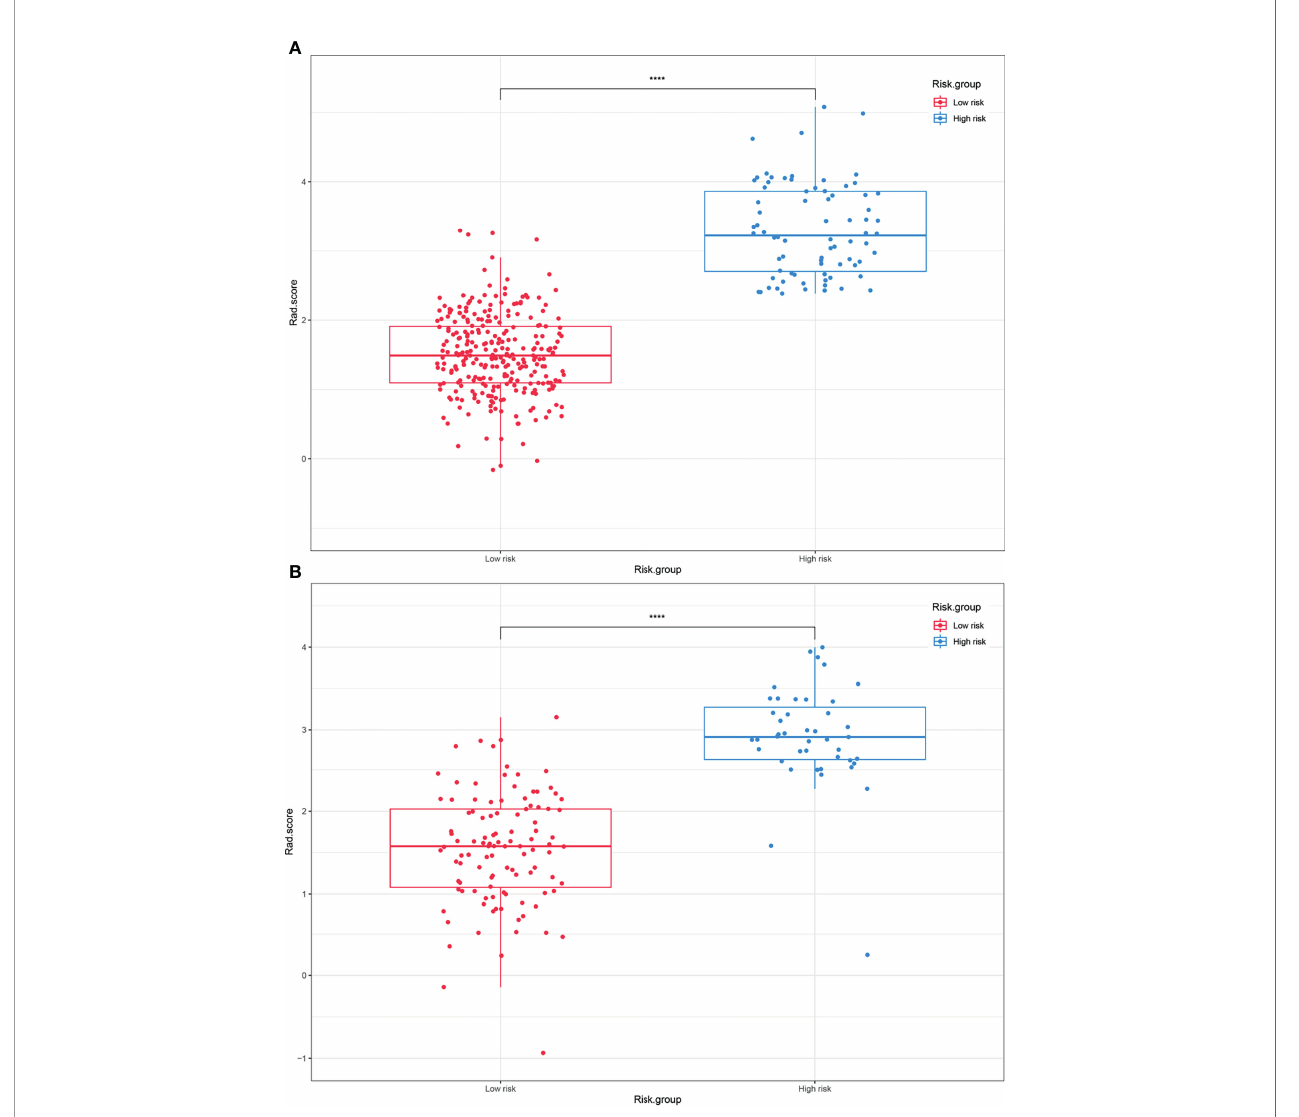
FIGURE 4 | Box plots of the low- and high-risk groups subdivided based on the Rad score-MS in the (A) training cohort and (B) validation cohort. **** p